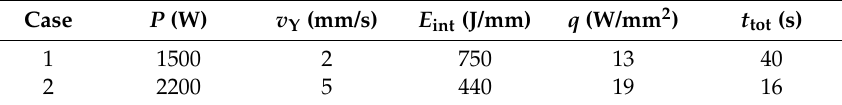
Table 6. Process parameters for Case 1 and Case 2.